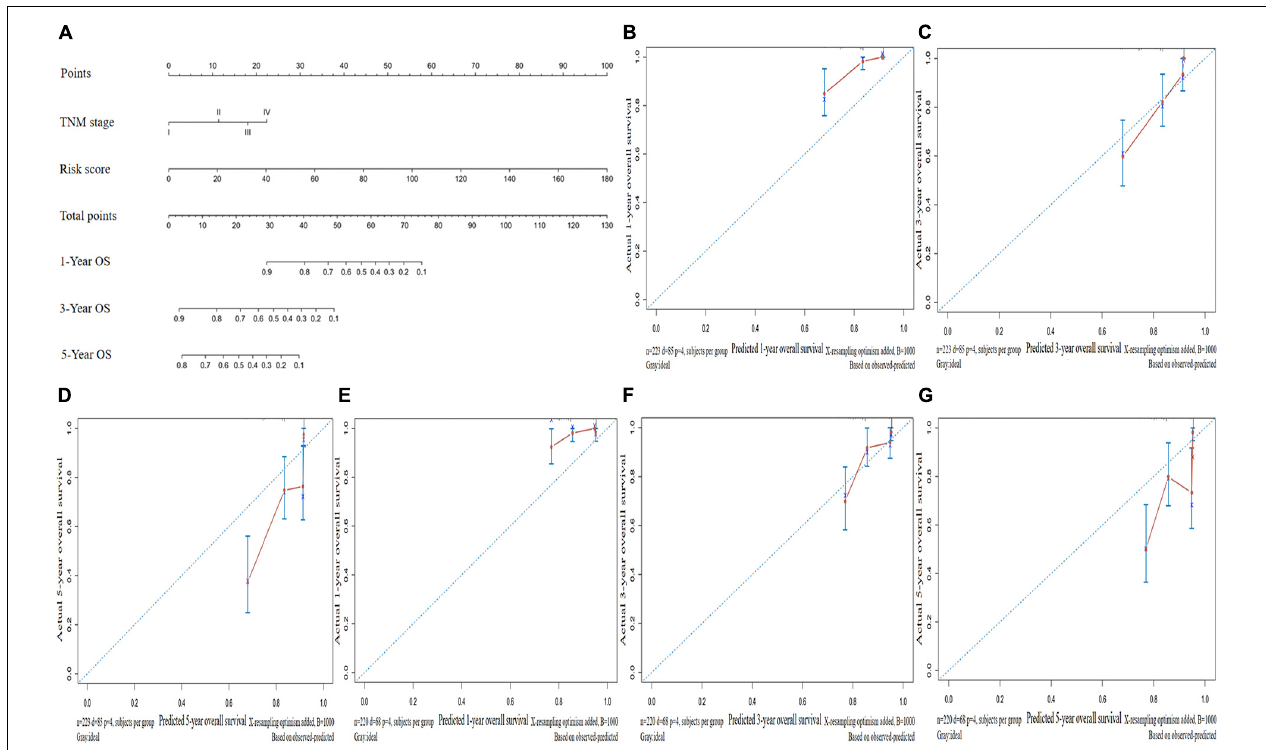
FIGURE 6 | Construction and validation of a predictive nomogram. (A) Nomogram for predicting the overall survival (OS) of patients with LUAD at 1, 3, and 5 years. Calibration curves of nomogram for OS prediction at 1, 3, and 5 years in the (B–D) training and (E–G) validation sets. LUAD, lung adenocarcinoma.